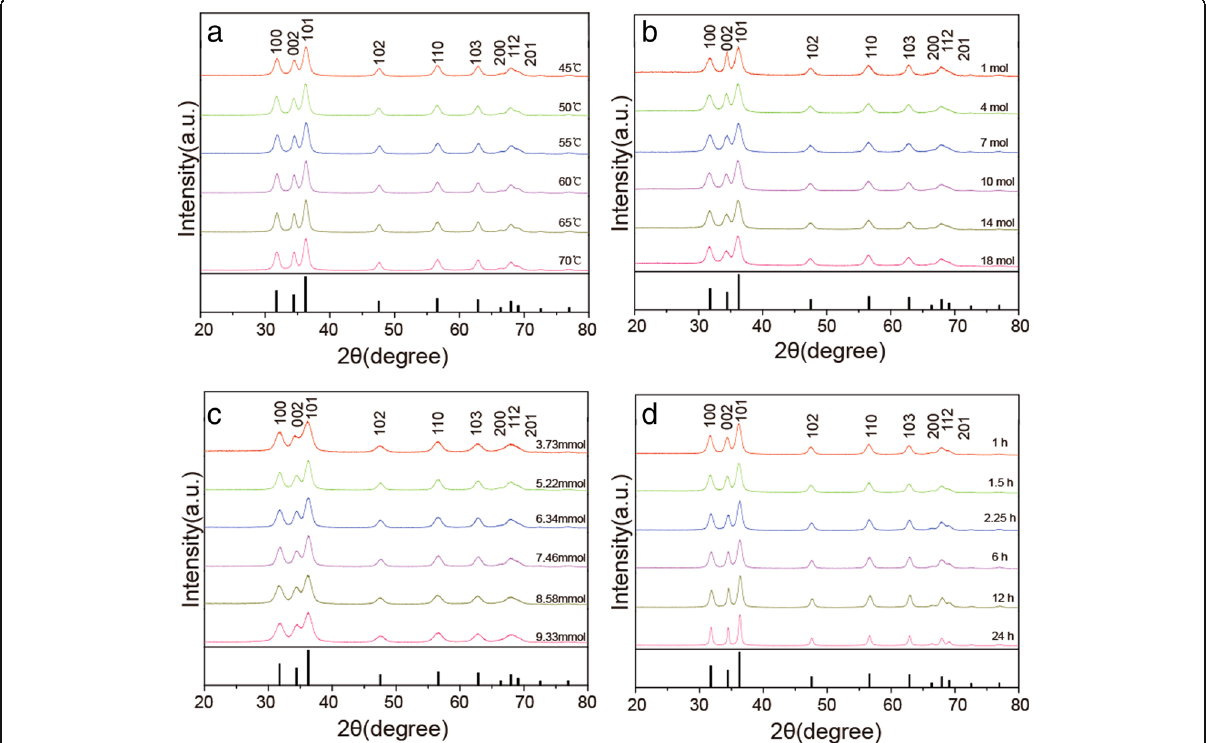
Fig. 2 XRD patterns of ZnO NPs obtained at different a reaction temperature, b moles of zinc acetate dihydrate, c moles of sodium hydroxide, and d reaction time. XRD pattern of bulk ZnO (according to JCPDS no. 36-1451) is shown at the bottom of each set of XRD